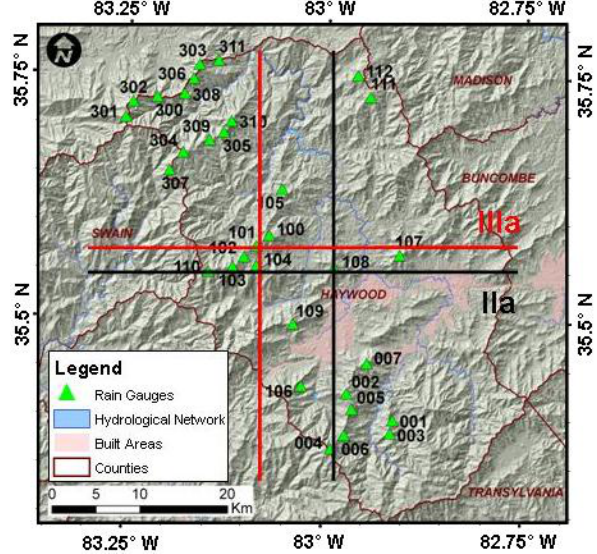
Fig. 1: Locations of the rain gauges constituting the GSMNP network in Haywood County, NC. Fig. 1. Locations of the rain gauges constituting the GSMNP net- work in Haywood County, NC. Rain gauges numbered 0XX and Rain gauges numbered 0XX and 1XX are used in this study. Rain gauges numbered 3XX installed 1XX are used in this study. Rain gauges numbered 3XX installed in summer 2009 are only here for representative purposes and are in summer 2009 are only here for representative purposes and are not included in the present study. not included in the present study. Figure is adapted from Prat and Figure is adapted from PB09a. Barros,